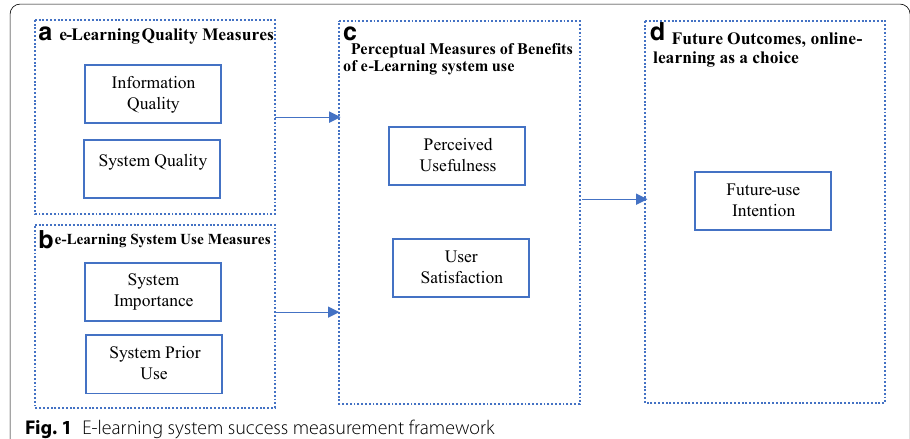
Fig. 1 E-learning system success measurement